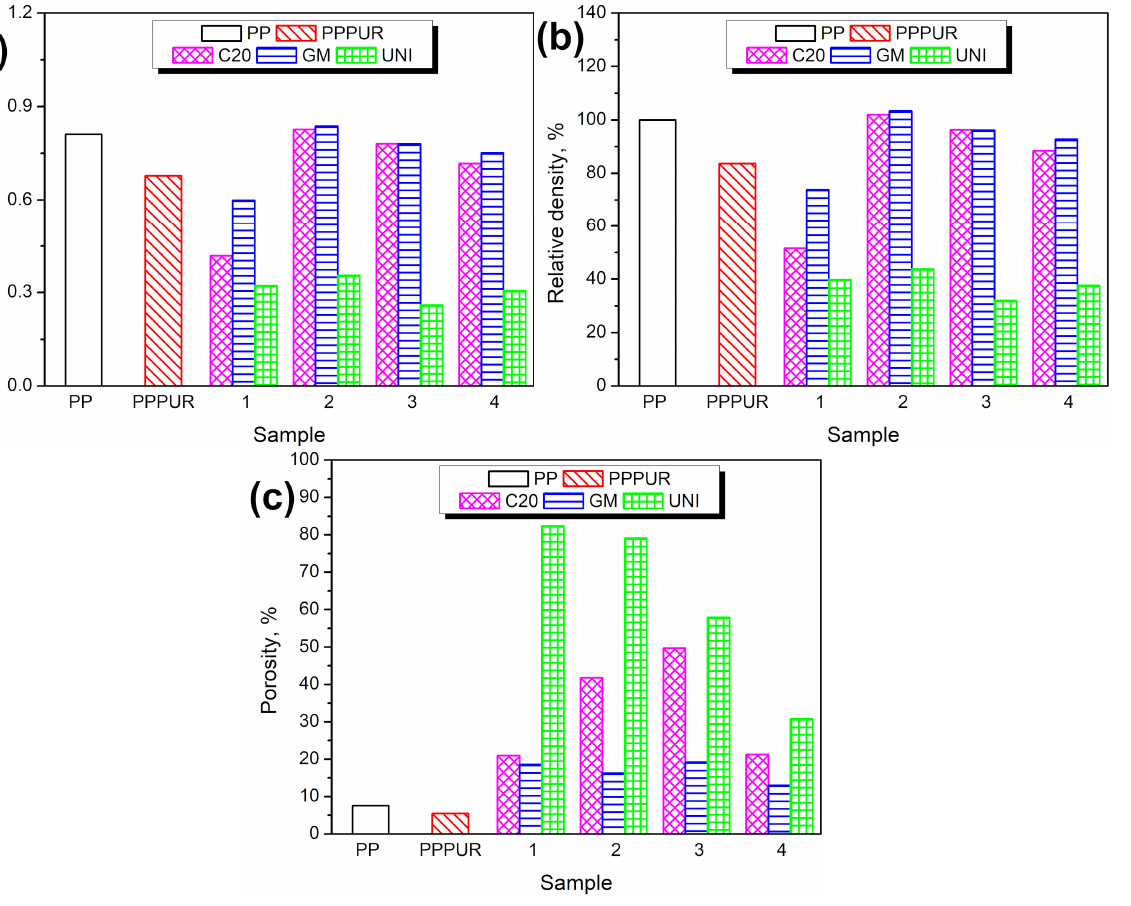
Figure 2. The impact of sample composition on ( a ) apparent density, ( b ) relative density, and ( c ) porosity.